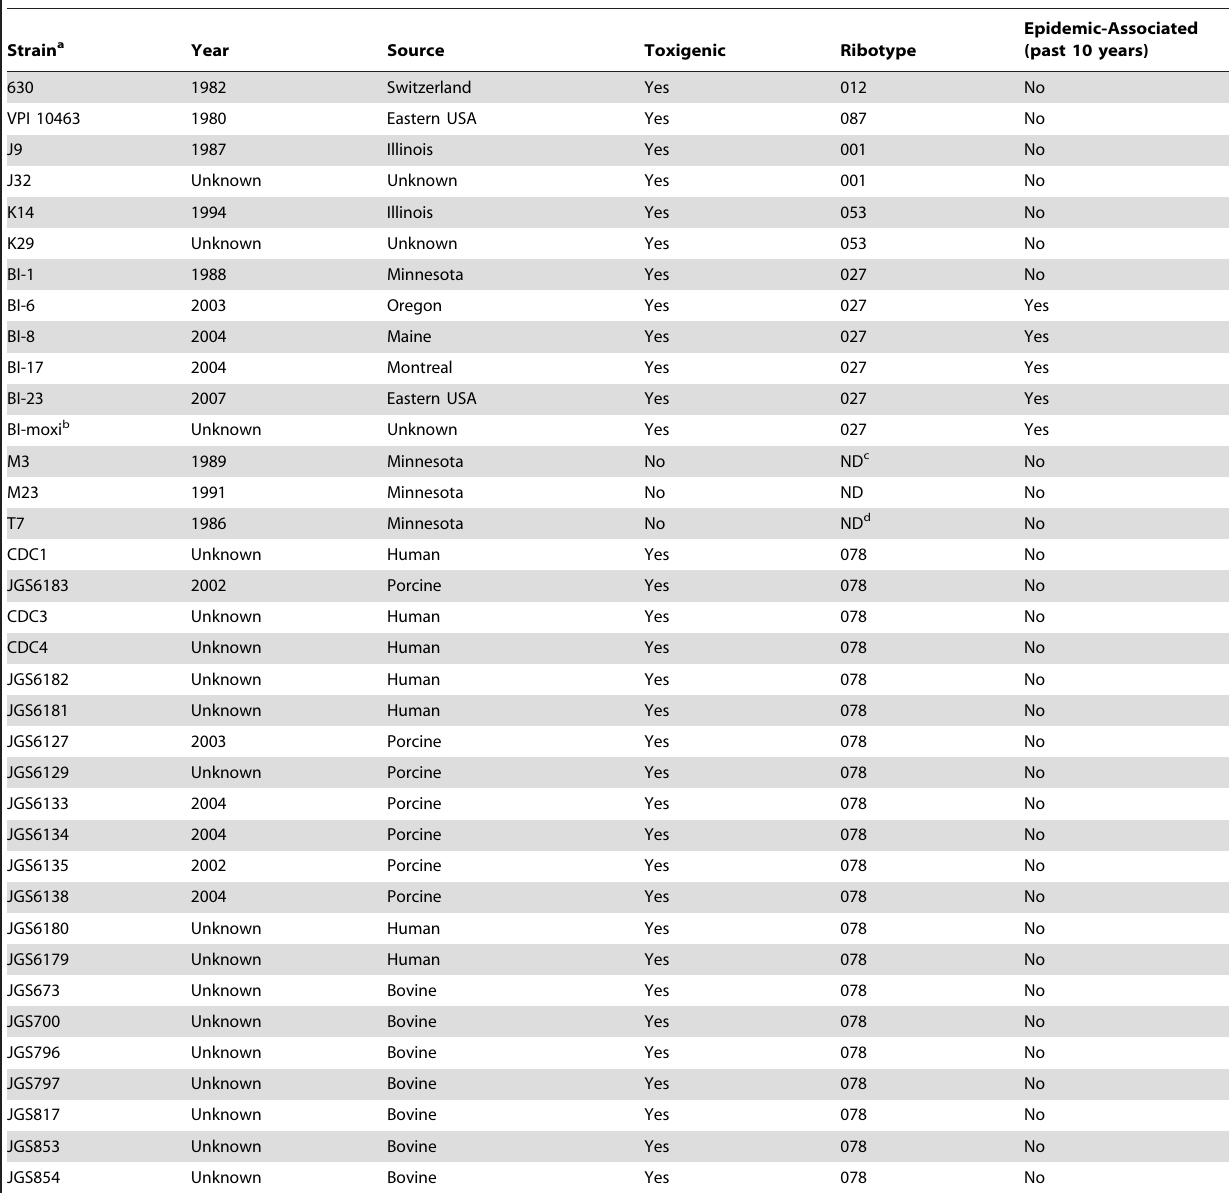
Table 1. C. difficile strains used in this